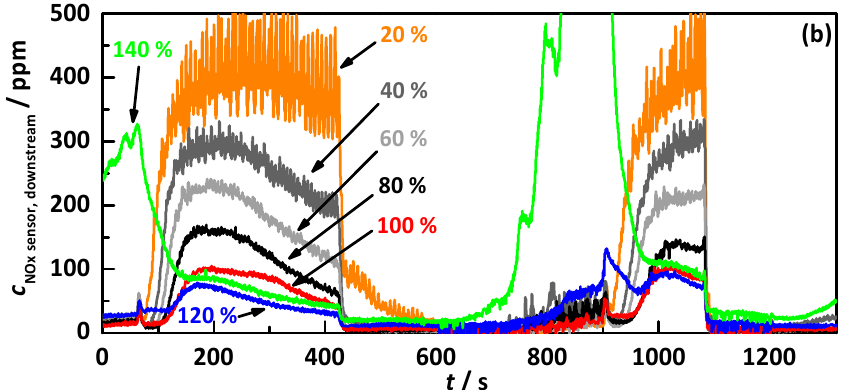
Figure 7. Comparison of the performed test cycles with percentage gradation of the ideal NH 3 storage curve controlled by Q 0–1 , with ( a ) the engine out NO x emissions (black) and the catalyst temperature (red) and ( b ) the signal of the downstream NO x sensor for 20 to 140% of the ideal storage curve.